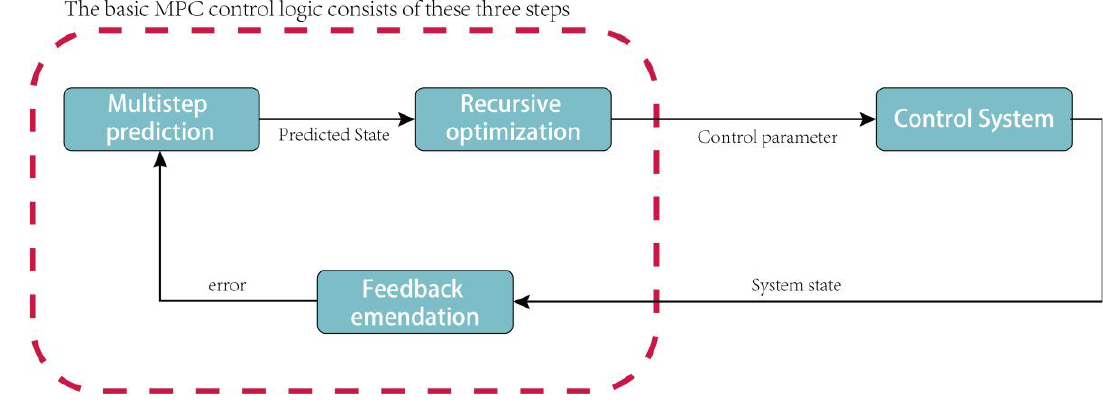
Figure 4. Basic structure of MPC.